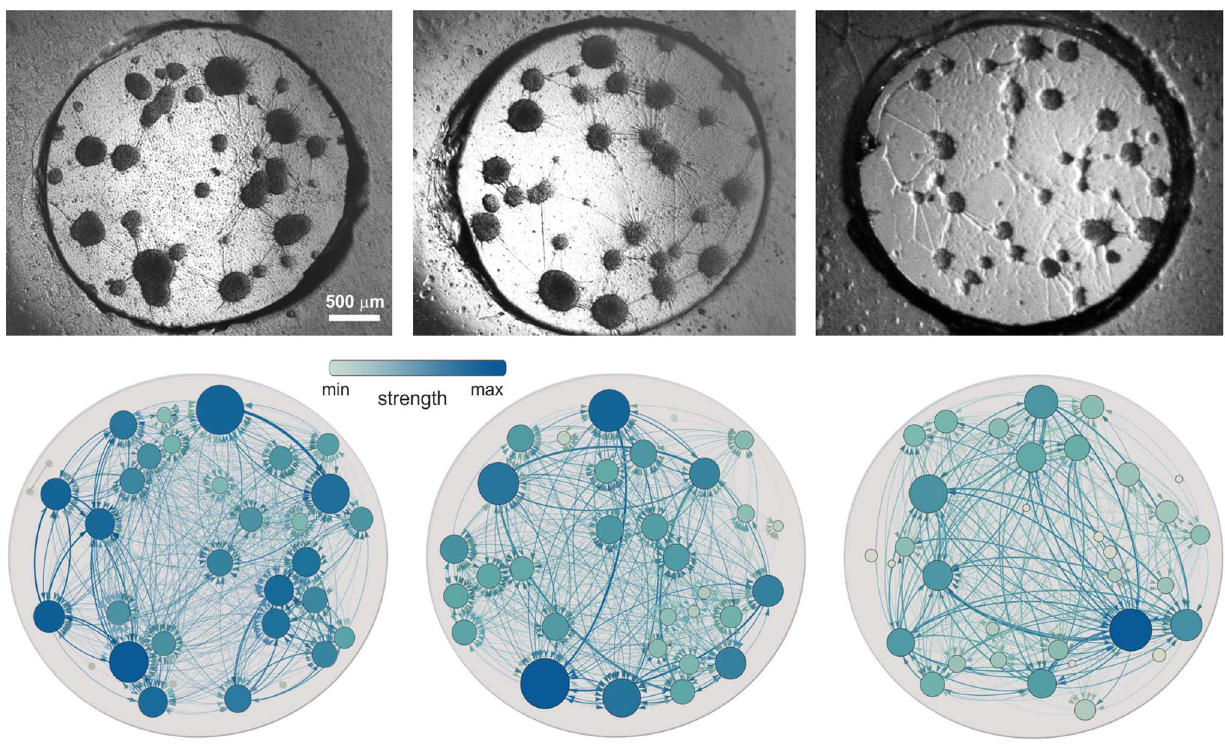
Figure 3. Neuronal cultures and functional networks. Top: Bright field images of 3 representative neuronal cultures at different days in vitro . Bottom: Corresponding functional networks obtained from the directed and weighed construction described in Figure 2. From left to right, the pictures correspond to the cultures labeled D, H and O in Table 1. Only active clusters are used in the construction of the functional network. The size of the nodes is similar to the ones observed in the cultures, and facilitates the comparison of the functional network with the real culture. In the functional networks, the edges are both color and thickness coded according to their weight, while the nodes are only color coded according to their strength. The darker the color, the higher the value.